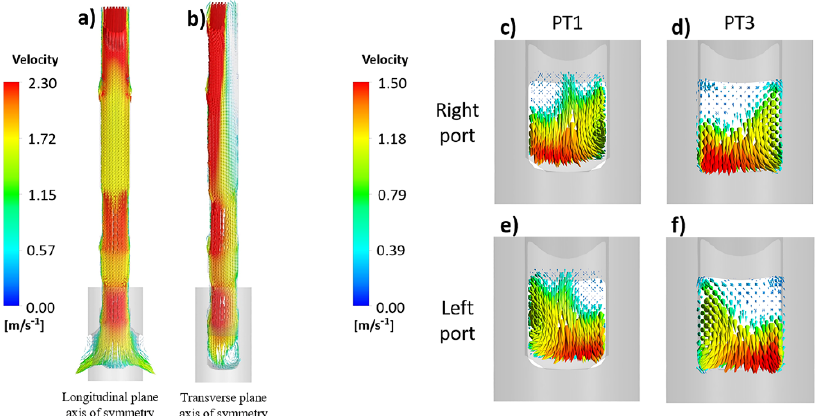
Figure 6. Numerical velocity fields in the nozzle: ( a ) longitudinal plane axis of symmetry, ( b ) trans- verse plane axis of symmetry. ( c ) Flow in the central plane of the internal axis of symmetry through the right port. ( d ) Flow through the outer port plane of the right port. ( e ) Flow in the central plane of the internal axis of symmetry through the left port. ( f ) Flow through the outer port plane of the left port.